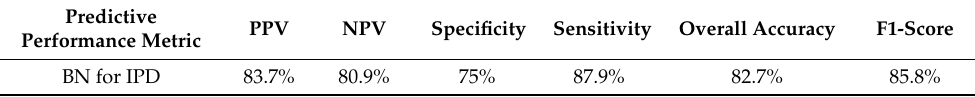
Table 14. Summary of predictive performance results of the BN learned for “NCPE”. The computed F1-score of almost 86% shows the classification prediction of the learned BN for NCPE is precise and